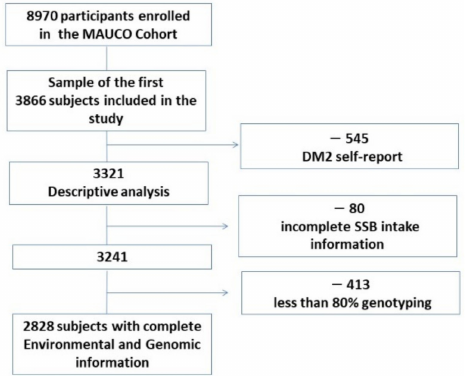
Figure 1. Number of participants and data filtering